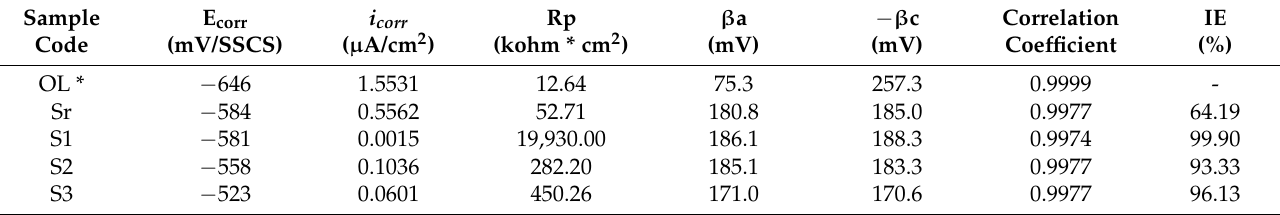
Figure 8. Potentiodynamic polarization (Tafel) curves for uncoated and coated samples in 3.5% NaCl solution at 25 °C (OL–the uncoated sheet/blank sample). Table 3. Electrochemical parameters calculated from Tafel polarization